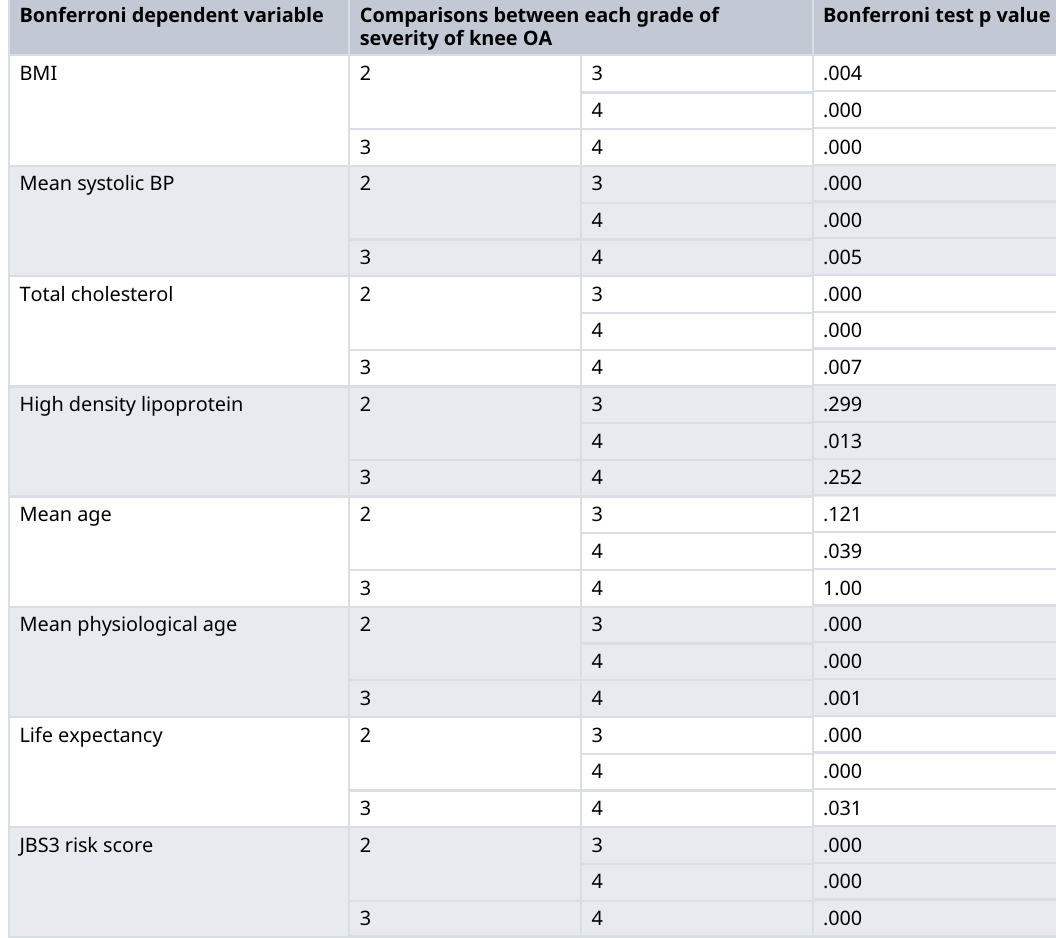
Table 3. Post hoc analysis of each of the variables using Bonferroni method and p value. p value <.05 is considered significant, p value <.01 is considered highly